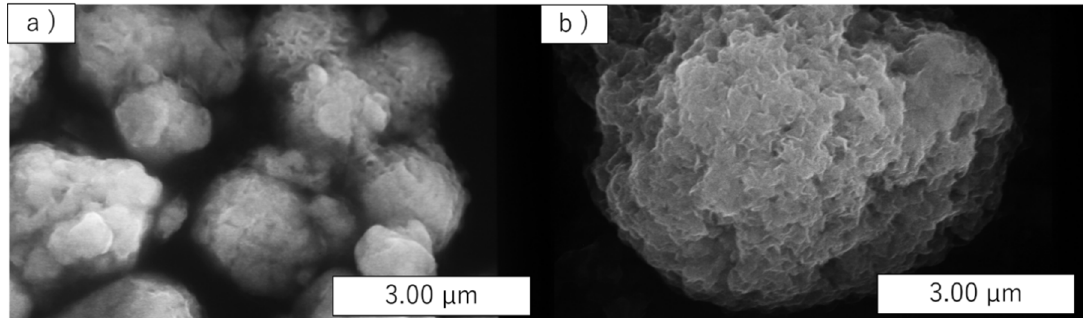
Figure 3. SEM images of ( a ) ZnIn 2 S 4 and ( b ) Zn 0.74 Cu 0.13 In 2 S 3.805 .